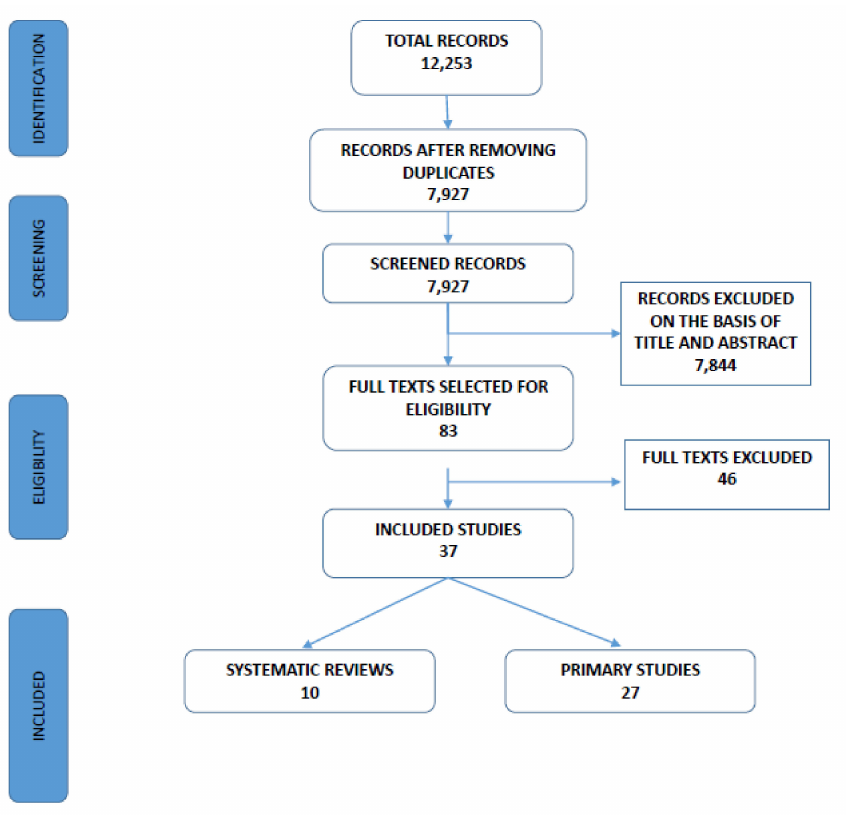
Figure 1. Flow diagram of the included